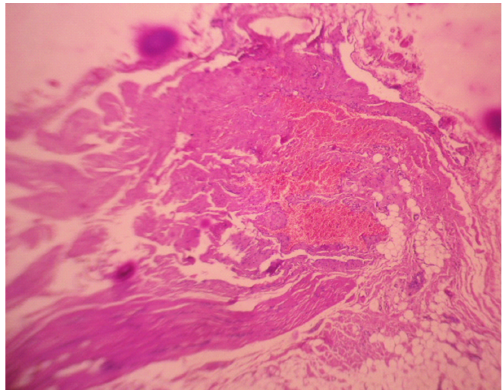
Figure 5: Microscopy shows skeletal muscle bundles and adipose tissue interspersed with large thick-walled blood vessels and few capillary-sized blood vessels filled with